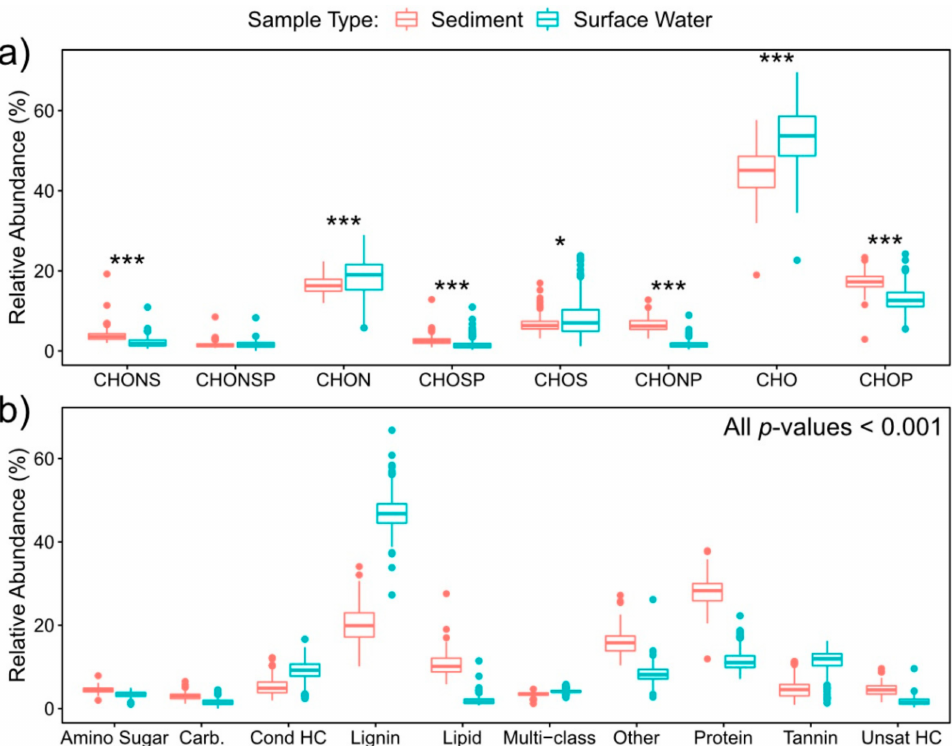
Figure 2. Box plots comparing the relative abundances of metabolites belonging to specific elemental groups ( a ) and chemical classes ( b ) between sediment and surface water. As in Figure 1, these values were obtained from all metabolites assigned molecular formulas in sediment and surface